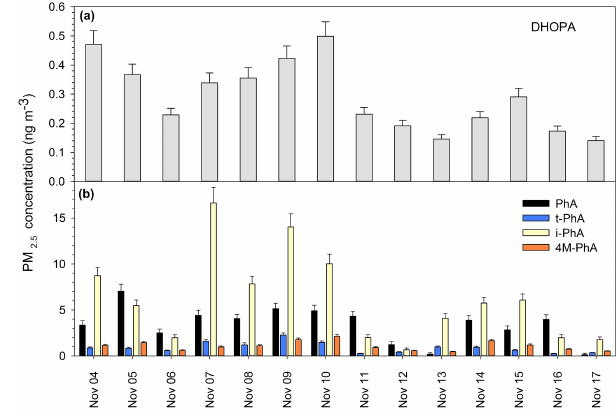
Figure 3. Daily PM 2 . 5 concentrations for 2,3-dihydroxy-4- oxopentanoic acid (a) and benzene dicarboxylic acids (b) , where PhA is phthalic acid, t-PhA is terephthalic acid, i-PhA is isophthalic acid, and 4M-PhA is 4-methylphthalic